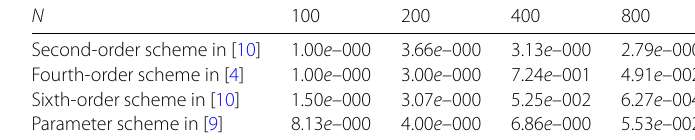
Figure 2 Development of the relative error with respect to